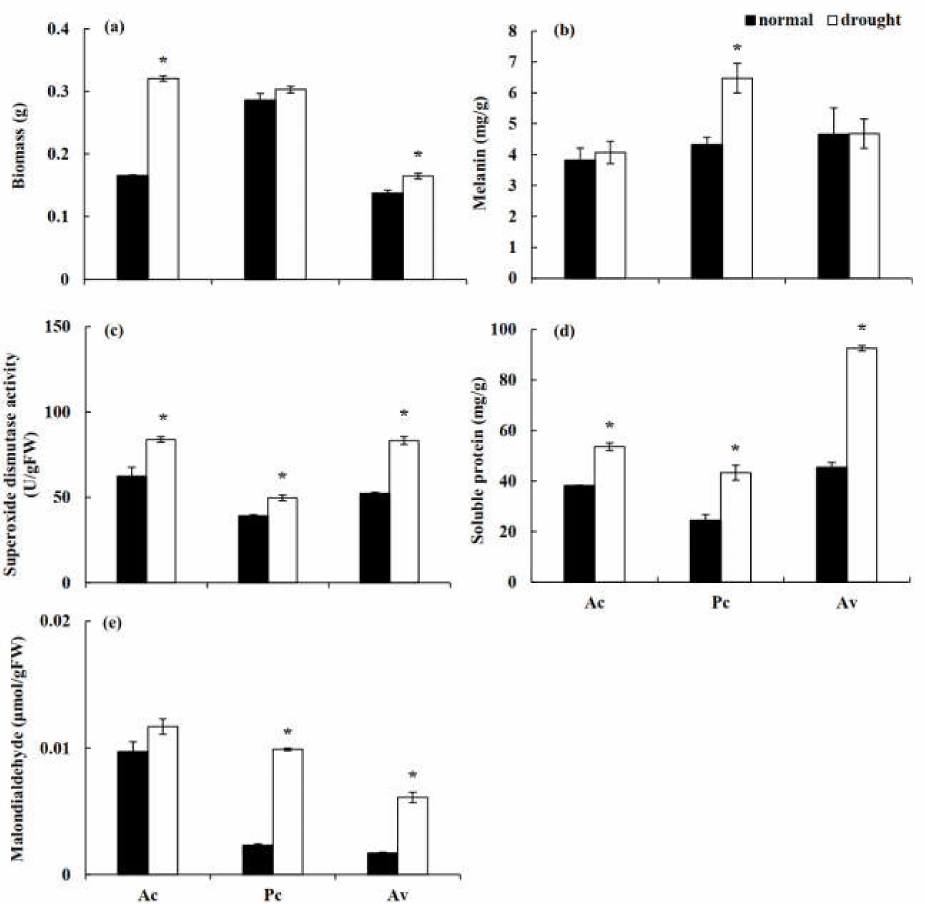
Figure 7. Biomass ( a ), melanin content ( b ), superoxide dismutase (SOD) activity ( c ), soluble protein ( d ), and malondialdehyde ( e ) content of three dark septate endophytes (DSEs) exposed to drought stress induced with polyethylene glycol (PEG) 6000. The asterisk above the error bars indicates significant difference between the normal and drought treatment of each DSE stain at p < 0.05. Note: Ac, Alternaria chartarum . Pc, Paraphoma chrysanthemicola . Av, Acrocalymma vagum